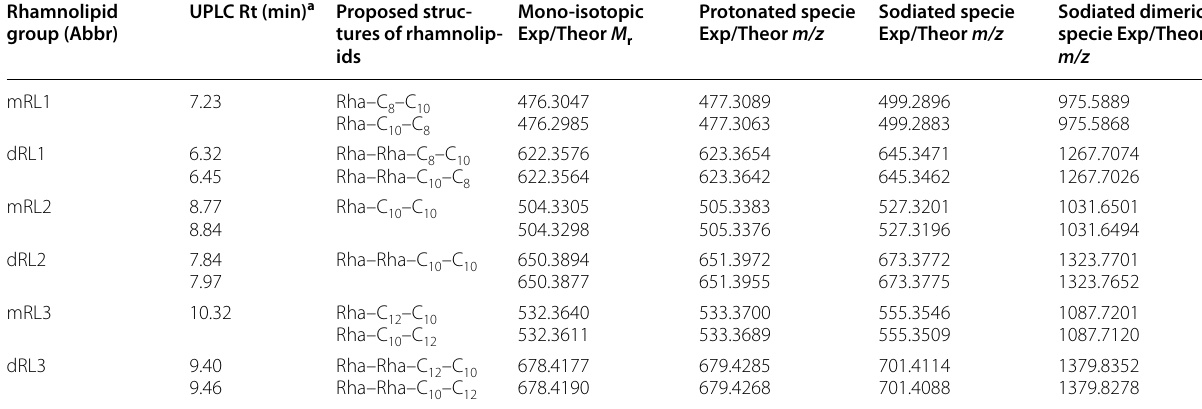
Their proposed chemical structures, theoretical (Theor) and experimental (Exp) M r and monoisotopic m/z values, as well as observed UPLC retention times for representative examples are provided a UPLC retention time of main peaks corresponding to the group’s m/z value